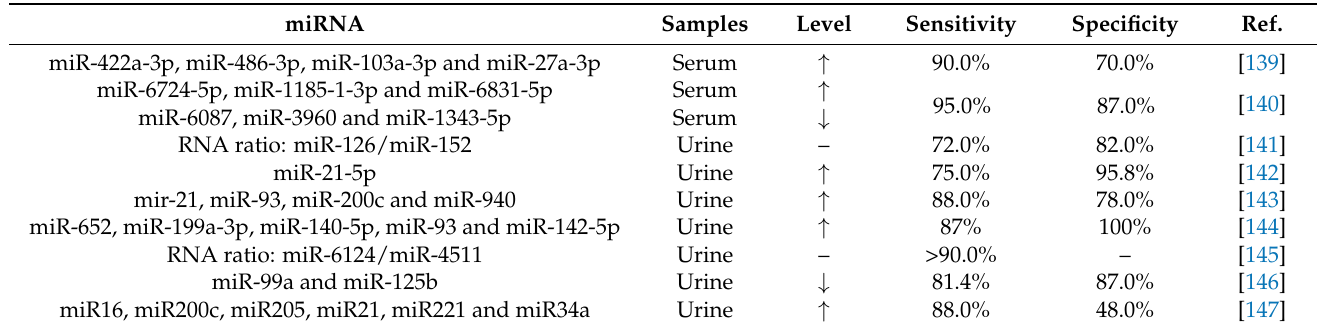
Table 5. miRNAs and their diagnostic potentials in urinary bladder cancer. miRNA Samples Level Sensitivity Specificity